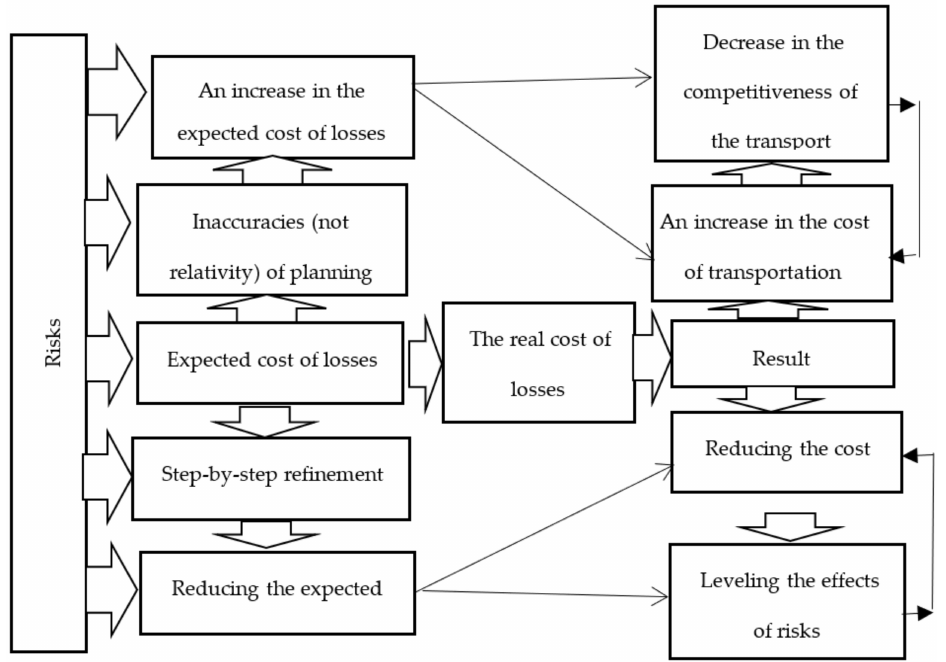
Figure 1. Algorithm for the systematic assessment of the dependence of the expected and real cost of losses on risks. Source: developed by the